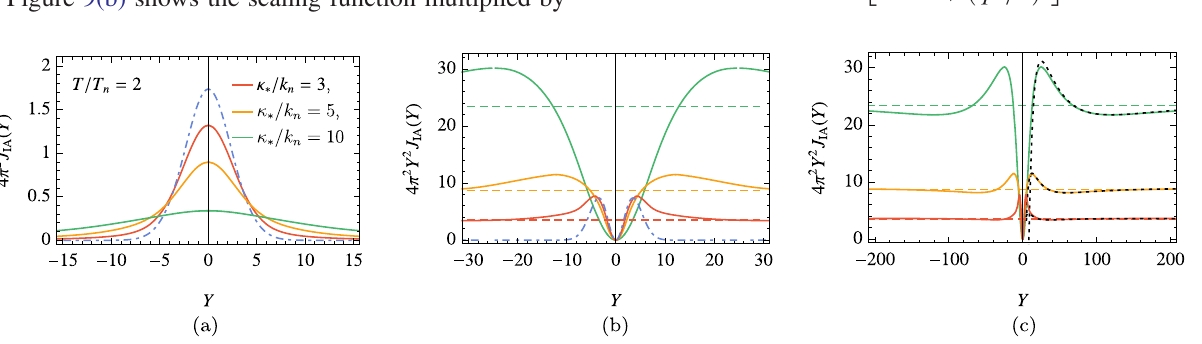
2 . The continuous n ¼ 3 , 5, and 10. For =k n ¼ (cid:4)